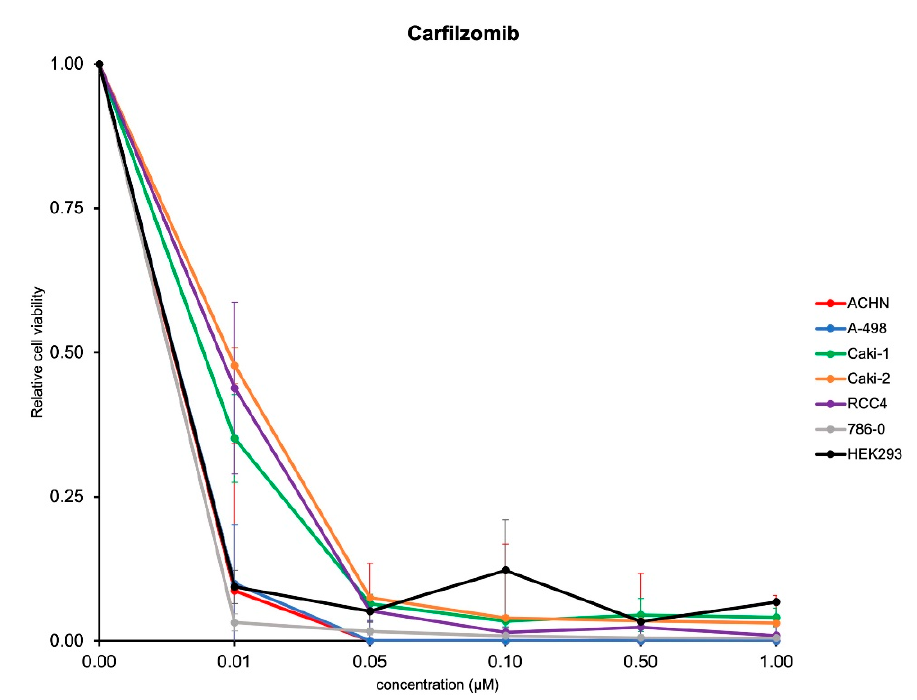
Figure 2. Carfilzomib exerts antitumoral activity in established RCC cell lines and HEK293 cells. Quantification of cell viability of established cell lines after treatment with carfilzomib for 72 h at the concentrations indicated. Results from three independent experiments (mean ± standard error) are shown after normalization to control (DMSO).